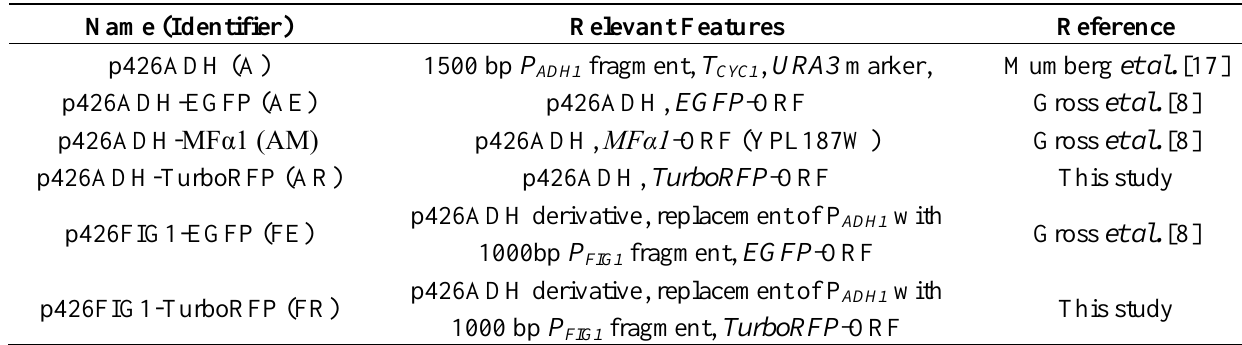
Figure 1. Immobilization of yeast cells in agarose compartments for microscopy and fluorescence scans. ( A , B ) Adjacent compartments of 5 × 5 mm were sequentially filled with agarose containing reporter cells (FP), or a source of α–factor (αF). See Supplementary Materials and Methods for details; ( C – E ) Microscopic imaging of the boundary region between agarose-embedded reporter cells (left) and plain agarose with diffusible α–factor (right). The boundary is visible as a blurred line (arrow). Cells